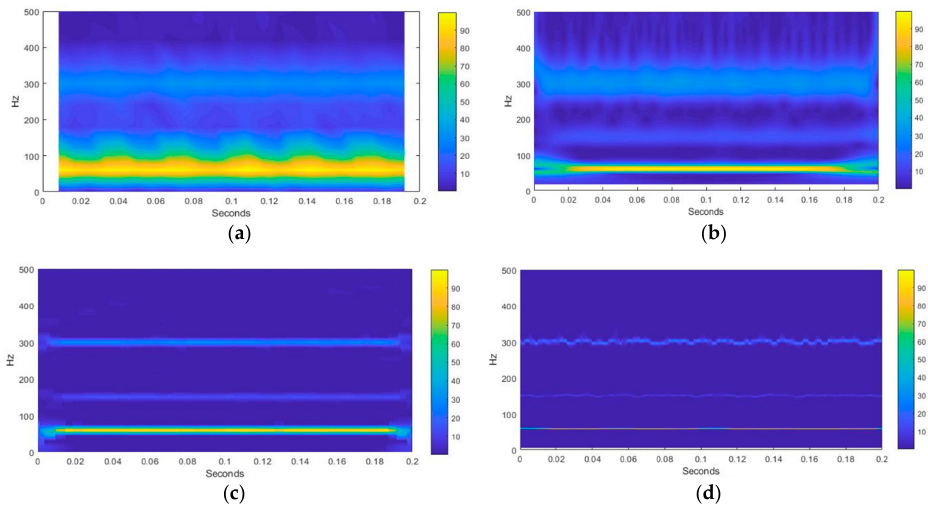
Figure 7. Performances of detection for the noise-contaminated signal of (13) using ( a ) STFT, ( b ) CWT, ( c ) FSST, ( d ) SSWT.